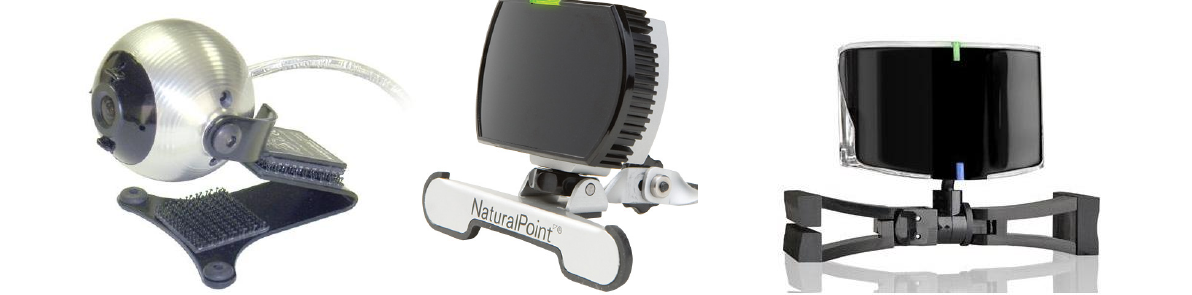
Figure 1. Left : Tracker Pro (Madentec). Center : SmartNav 4 AT (NaturalPoint). Right : TrackIR 4